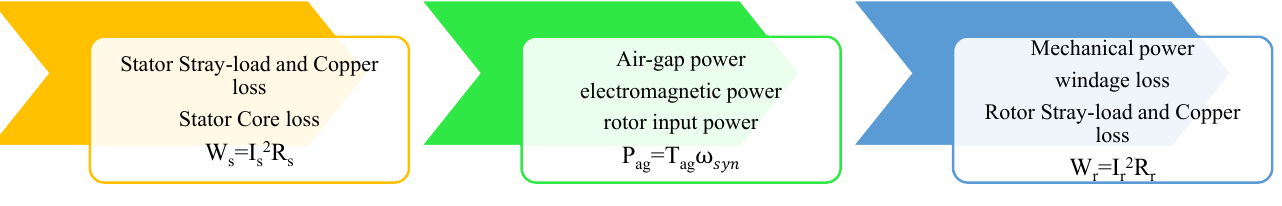
Figure 1. Power losses inside IM [11].